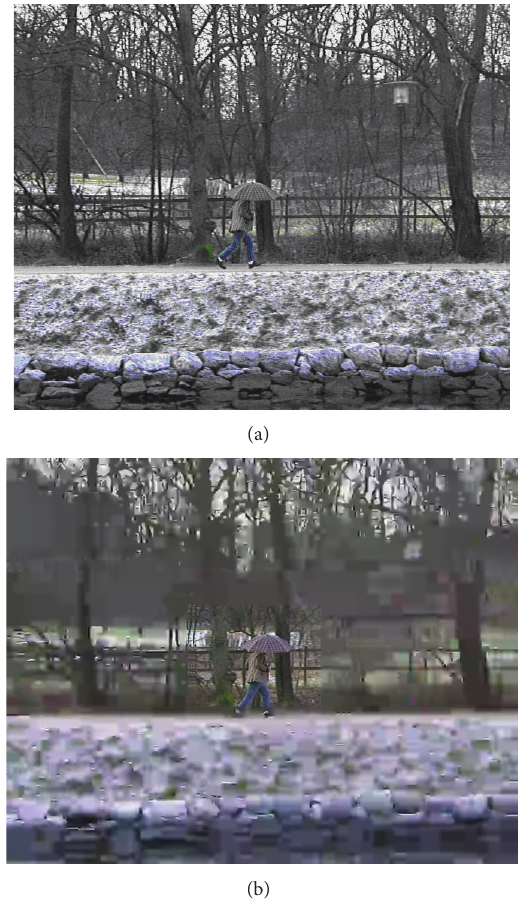
Figure 11: The “PARKRUN” video sequence containing the ROI region in the middle of the frame, the man with an umbrella (the quantization parameter of the background region is determined adaptively); (a) the original frame; and (b) the compressed frame with the higher-quality ROI